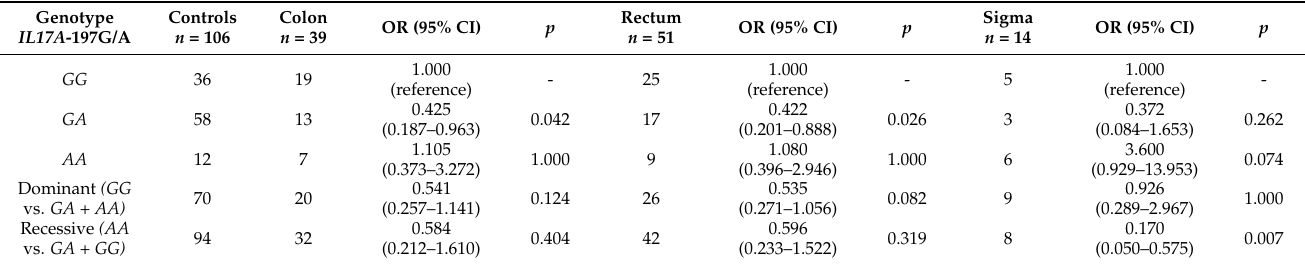
Table 4. IL17A -197G/A SNP frequencies and OR in colon, rectal and sigma cancer cases and controls.